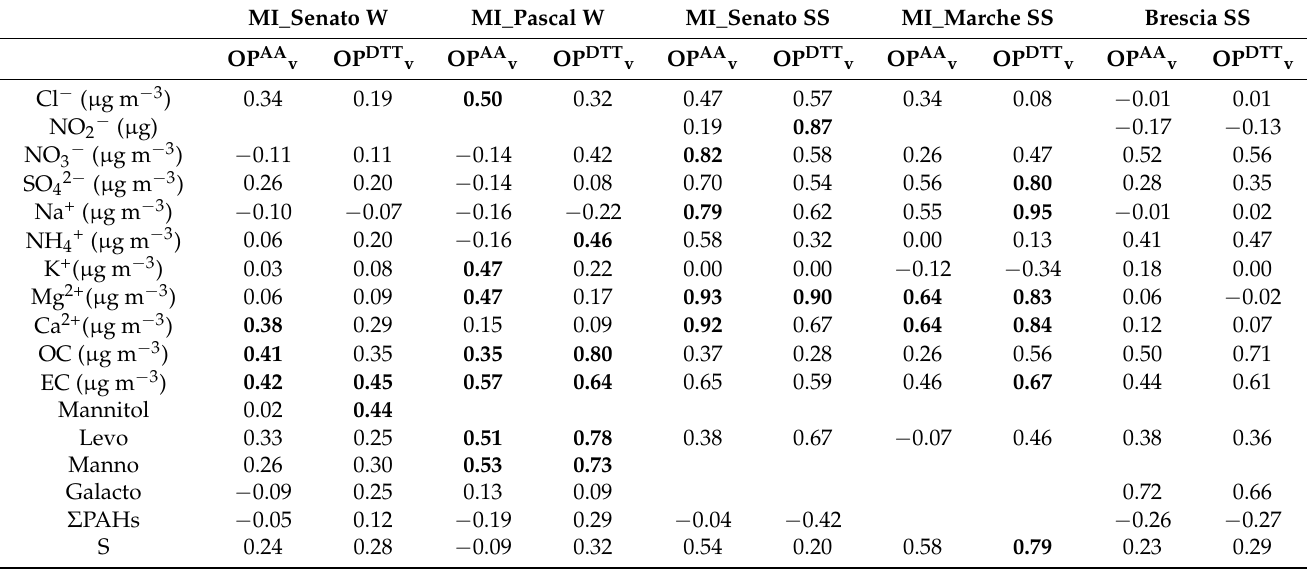
Table 5. Pearson’s correlation coefficients ( r ) between the OP DTT V and OP AA V responses and the PM 10 chemical components in winter campaigns at MI_Senato and MI_Pascal ad spring/summer periods at MI_Senato, MI_Marche and Brescia